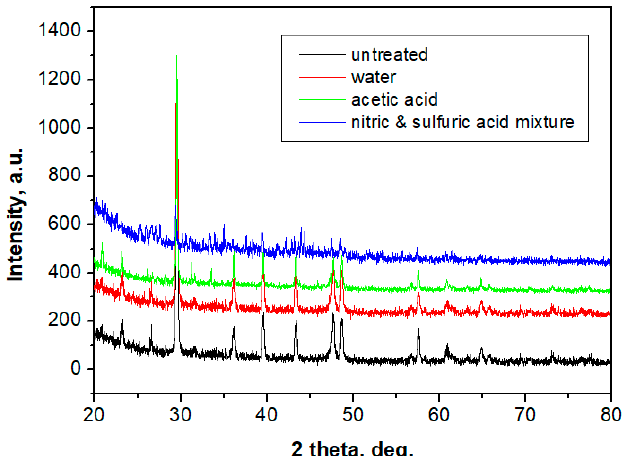
Figure 12. XRD patterns obtained for the exterior area of the ( a ) control group; ( b ) group exposed to rain water; ( c ) group exposed to acetic acid; and ( d ) group exposed to nitric and sulfuric acid mixture. All XRD peaks belong to calcite.